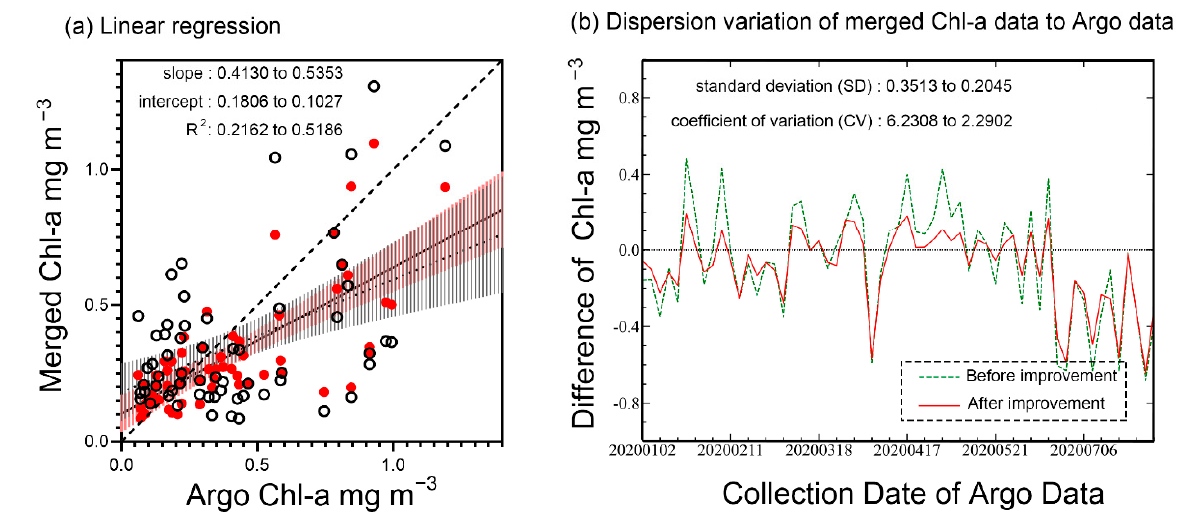
Figure 10. Validation of merged Chl-a data. ( a ) Linear regression of Argo data and merged data. The black hollow points are the default matched data, and the red solid points are the data based on the blending algorithms. The thick dashed line is x = y. The thin dashed line is the default algorithm merged data line. The black line is the improved fitting line. ( b ) The variation of difference value between merged data and Argo data with the collection time. The green dashed line is variation of the merged data before improvement. The red line is the variation of improved merged data.